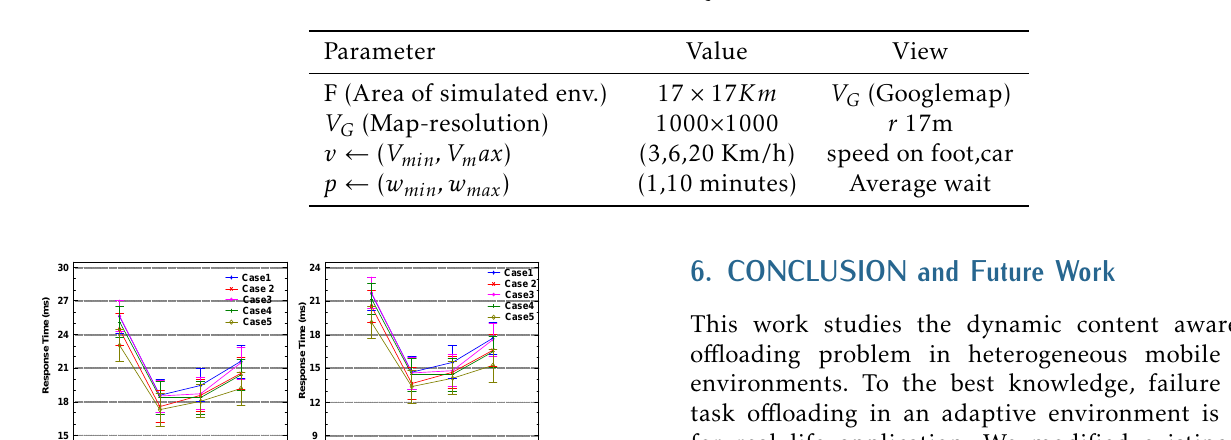
Table 8. Mobility Dataset